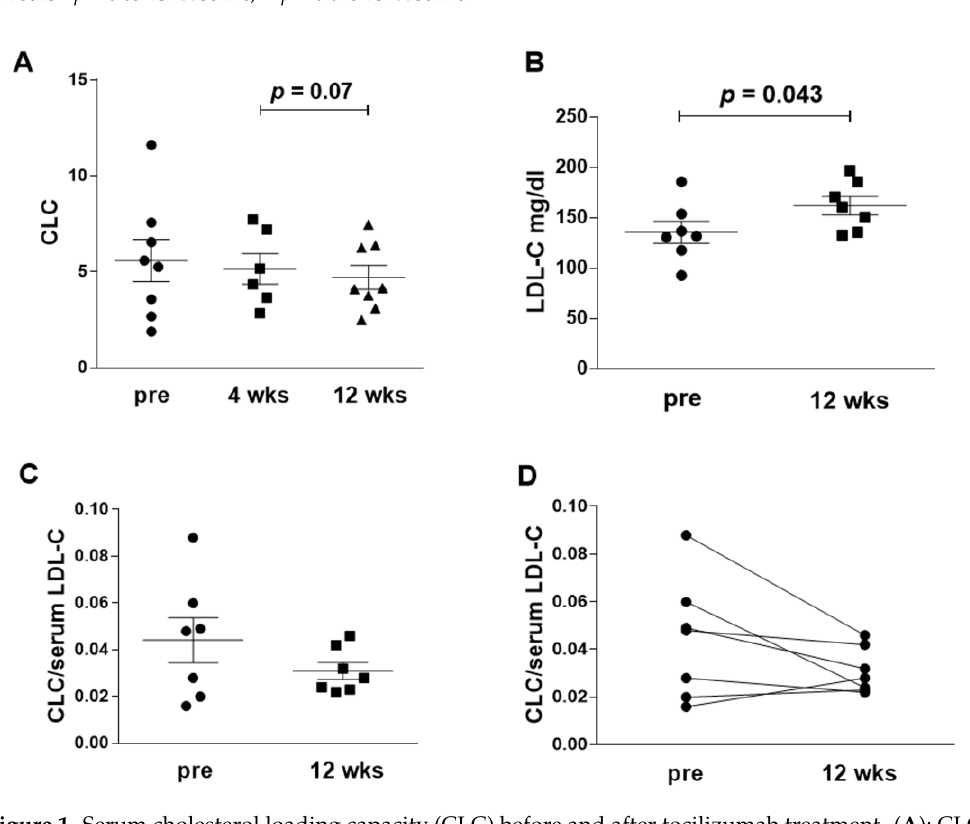
Figure 1. Serum cholesterol loading capacity (CLC) before and after tocilizumab treatment. ( A ): CLC, expressed as mg cholesterol / µ g DNA in macrophage cells extracts, at baseline (pre), after 4 weeks (4 wks) and 12 weeks (12 wks) of tocilizumab treatment ( B ): LDL-cholesterol (LDL-C) serum level (mg / dL) at baseline and after 12 weeks of treatment. ( C ): the panel reports the ratio CLC / LDL-C in each patient at the two time points. ( D ): the panel shows the change with time of CLC / LDL-C ratio in each patient. Statistical significance was calculated with the Wilcoxon test for paired samples with skewed distribution.